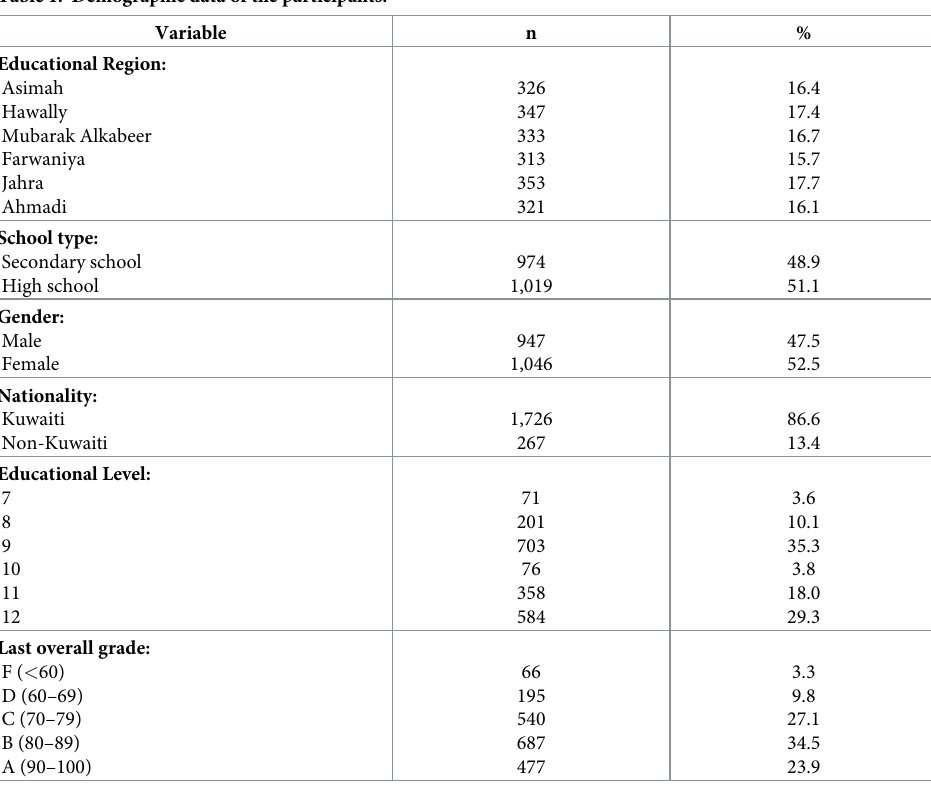
Table 1. Demographic data of the